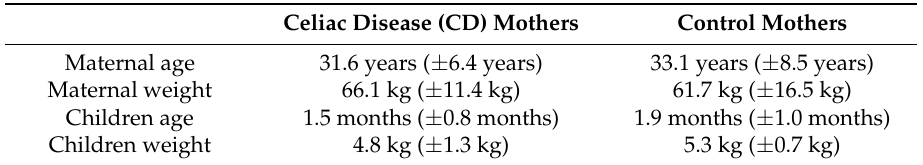
Table 1. Demographic data at sampling time for both mothers’ groups are represented as mean ( ± standard deviation).